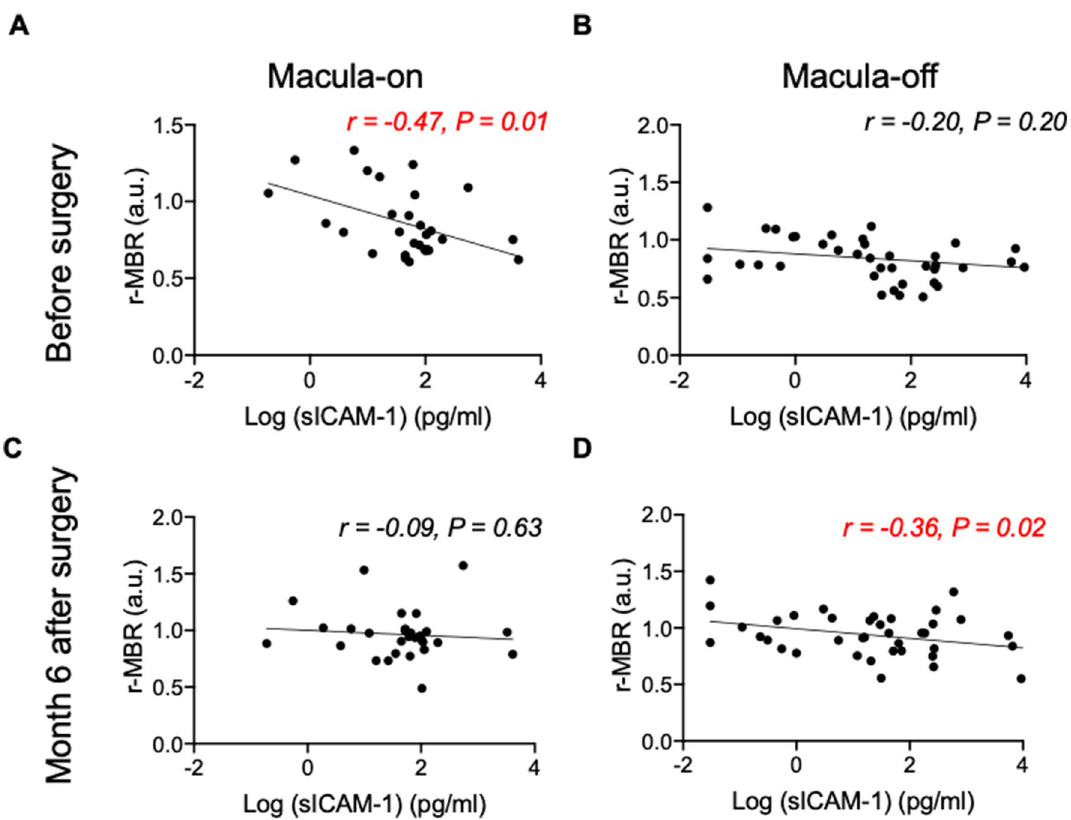
Figure 3. Relationship between sICAM-1 and relative MBR (r-MBR, RRD/fellow eye) in macula-on and -off RRD ( A–D ). Log-transformed levels of sICAM-1 in aqueous humor were significantly negatively correlated with vessel MBR ratio (RRD eye/fellow eye) before surgery in macula-on RRD ( r = − 0.47, P = 0.01). In macula- off RRD, log (sICAM-1) was negatively correlated with vessel MBR ratio 3 months ( r = − 0.36, P = 0.02) and 6 months ( r = − 0.36, P = 0.02)